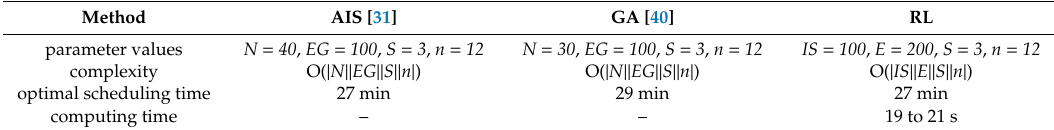
Table 3. The complexity and optimal scheduling time of three